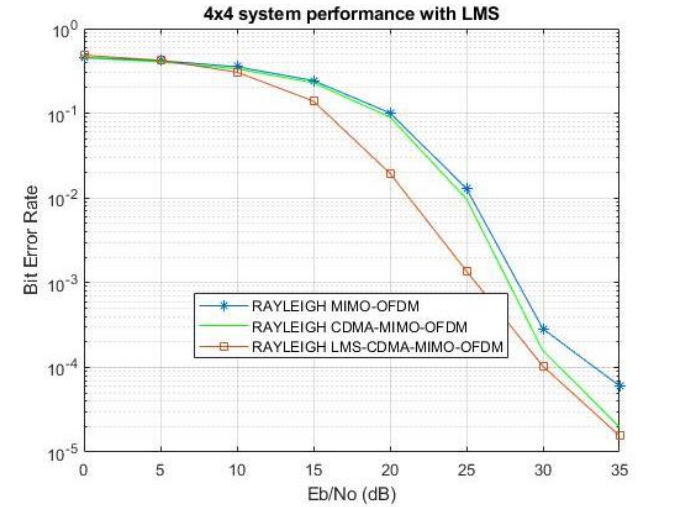
Figure 19. SNR vs. BER plot for 4×4 LMS-MIMO-OFDM model in Rayleigh